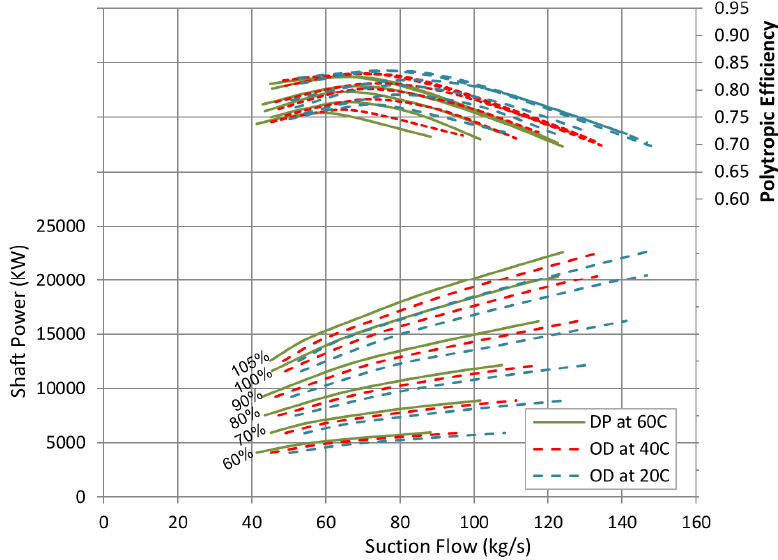
Figure 17. Effect of suction pressure and temperature on the compressor efficiency and shaft